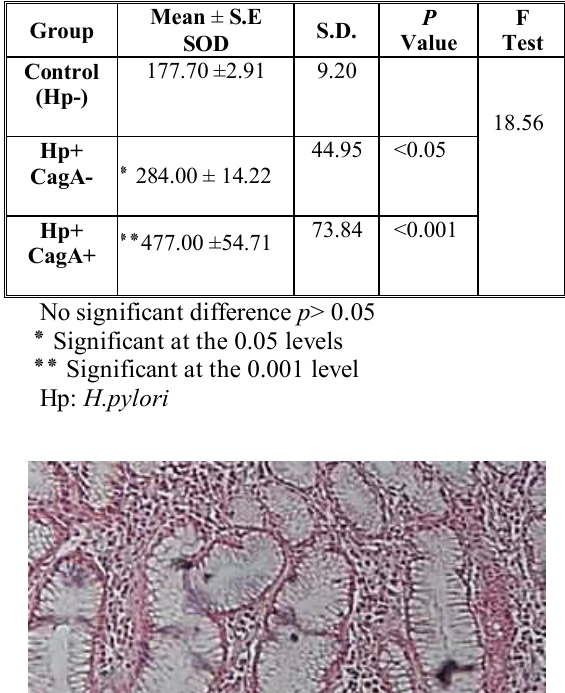
Table( 2): The serum level of SOD in patients infected with H.pylori and CagA status.